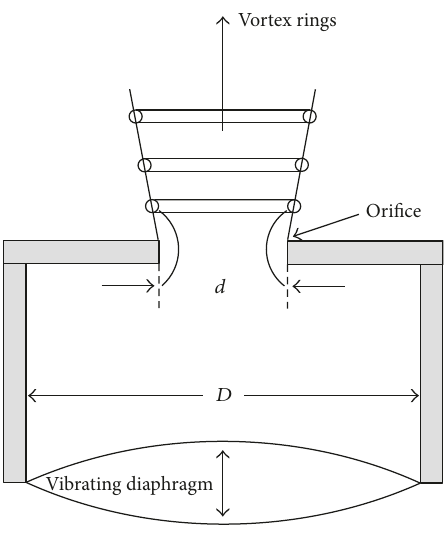
Figure 1: Schematic for a synthetic jet